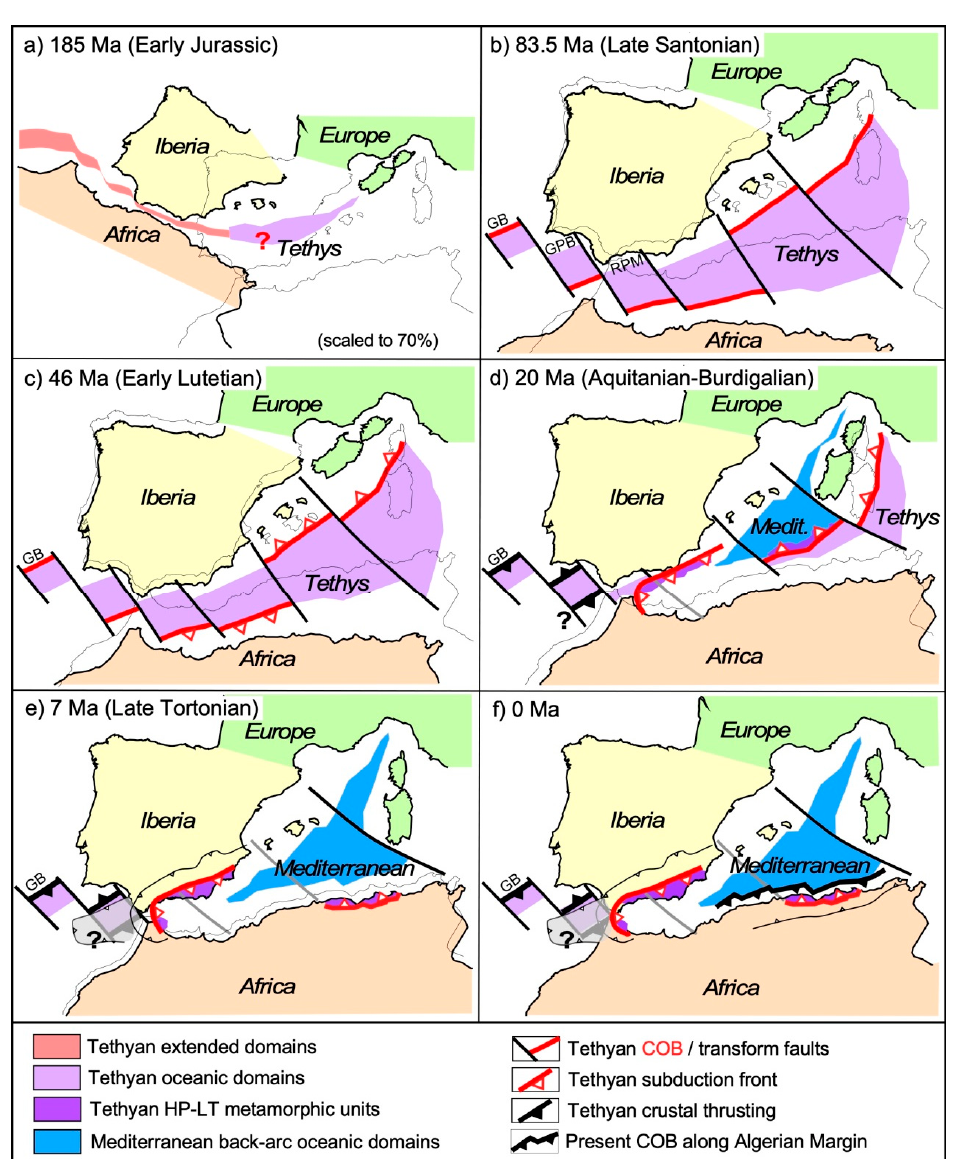
Figure 5. Sketch summarizing the tectonic evolution of the Iberia–Africa plate boundary since the Early Jurassic: ( a ) oceanic spreading in the Central Atlantic with eastward displacement of Africa relative to Iberia and opening of the Ligurian–Tethys; ( b ) initiation of N–S Iberia–Africa convergence and end of extension in the Ligurian–Tethys segments; ( c ) development of thrusting and subduction with opposite polarity in the Ligurian–Tethys segments; ( d ) roll-back of the subducted Ligurian–Tethys segments and generation of the present Mediterranean; ( e ) end of roll-back of the Ligurian–Tethys slabs and stacking of the high-pressure / low-temperature (HP / LT) units in the Betic–Rif Arc and the Kabylies; and ( f ) possible initiation of S–SE directed subduction of the Mediterranean domain beneath north–Africa. COB: continental-oceanic boundary; GB: Gorringe Bank; GPB: Guadalquivir–Portimao Bank; RPM: Ronda Peridotite Massif. Plate reconstruction from 83.5 Ma to present taken from the work of